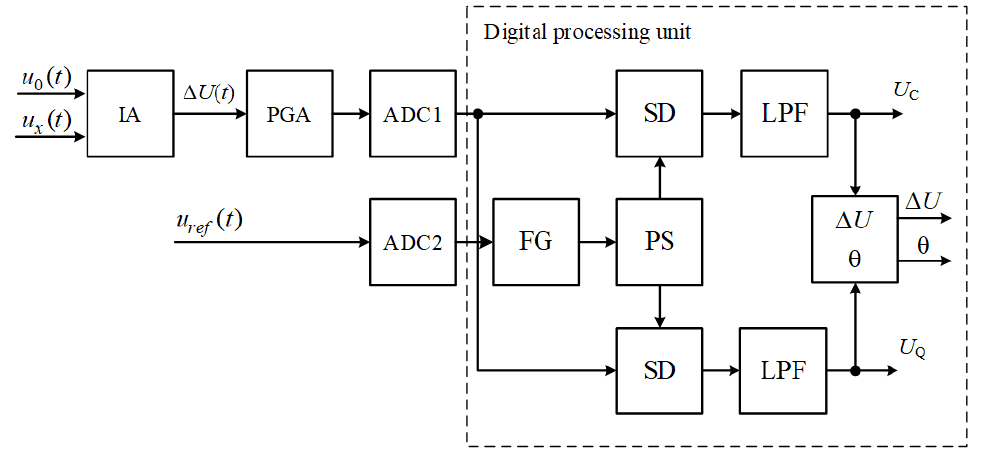
Figure 1. Flowchart of commercially available lock-in amplifier.